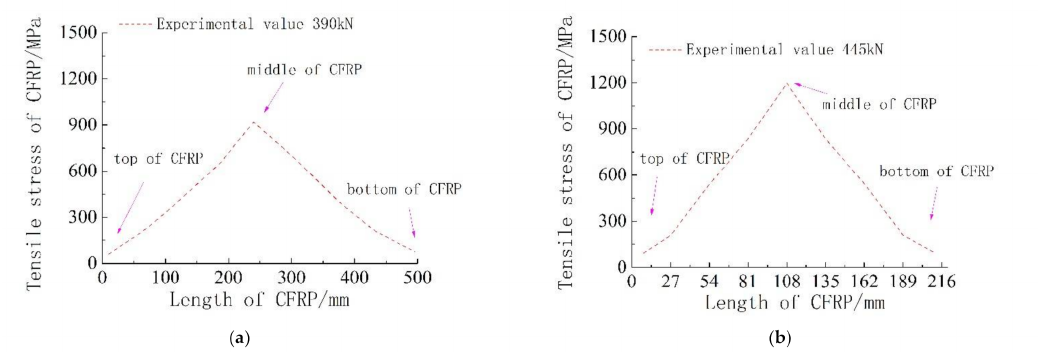
Figure 15. Tensile stress of middle CFRP bar in strengthened beams: ( a ) Middle CFRP bar’s tensile stress in Scheme I; ( b ) Middle CFRP bar’s tensile stress in Scheme II.